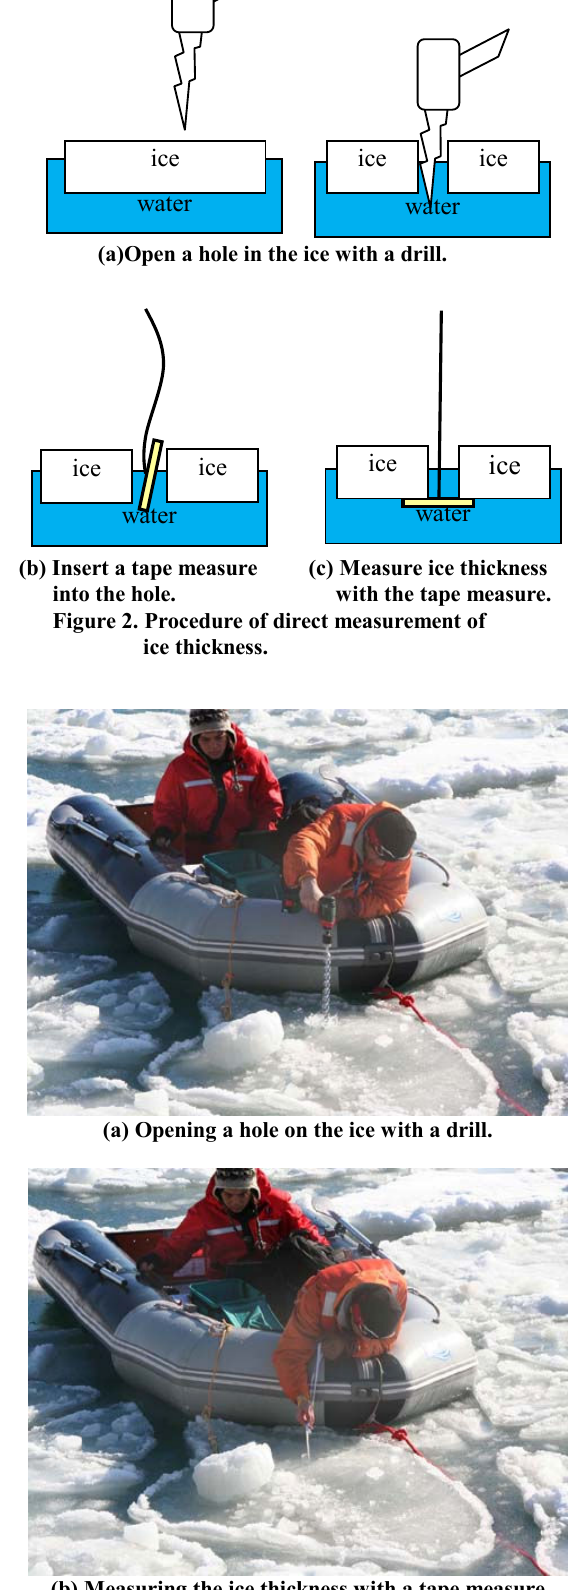
Figure 3. Direct measurement of ice thickness from a